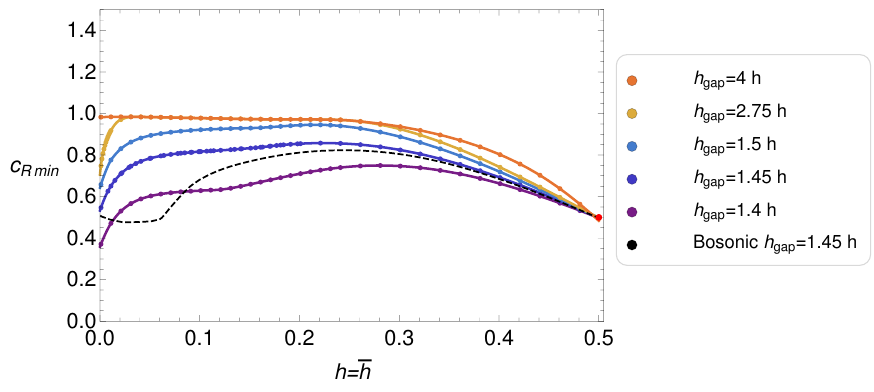
Figure 1 . Lower bound on the allowed right central charge c R (non-supersymmetric side) of N = (2 ; 0) SCFTs as a function of the external dimension, h = (cid:22) h , after imposing di(cid:11)erent gaps on the spectrum of superprimary scalar operators h gap = (cid:22) h gap . The lines with dots correspond to the full set of crossing equations. The dashed black line corresponds to the bound obtained from the crossing equations of the superconformal primary alone, which matches with the bosonic bootstrap bounds, and is obtained for a single h gap = 1 : 45 h . The red dot marks the central charge and external dimension of the known (2 ; 2) and (2 ; 0) minimal models described below eq. (3.3) (see text for discussion). The bounds were obtained for (cid:3) = 20 which, with the shown scale is